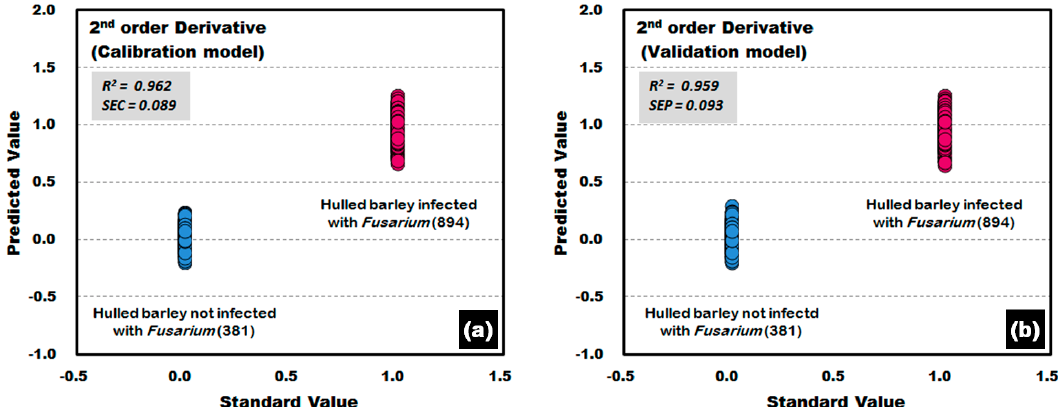
Figure 16. Fusarium discrimination calibration ( a ) and validation ( b ) results of the PLS-DA model developed by using the raw reflectance spectra obtained from the back side of the hulled barley.